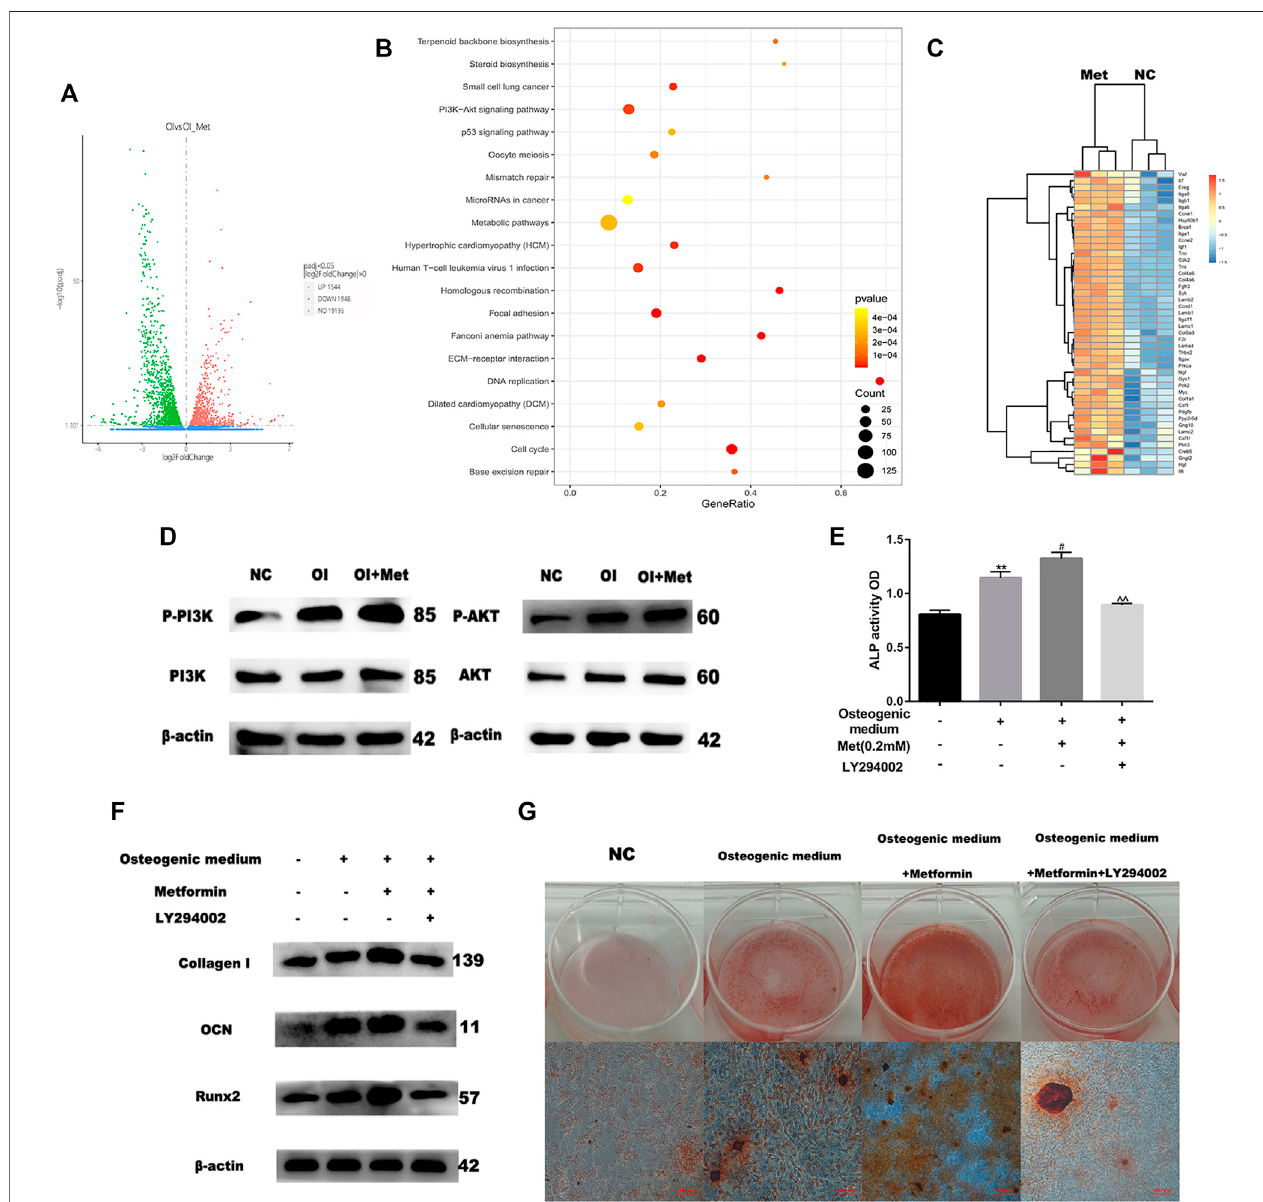
FIGURE 2 | Metformin induces osteogenic differentiation via the PI3K/AKT pathway. (A) Volcano map of differential genes as osteogenic induction (OI) vs. OI with metformin treatment (OI_Met). (B) Kyoto Encyclopedia of Genes and Genomes (KEGG) of up-regulated genes during metformin-induced osteogenic differentiation. (C) Heatmap of up-regulated genes involved in PI3K/AKT signaling pathway. (D) Protein expression of PI3K-AKT pathway, enhancing effect observed for metformin on PI3K/AKT expression. (E) ALP activity was detected to explicit metformin protection of osteogenic differentiation inhibited by H 2 O 2 was blocked by LY294002. (F) Protein expression of COLL-1, OCN and Runx2 after adding LY294002. (G) The activity of osteoblast mineralization decreased with LY294002 treatment detected by using Alizarin red S staining. Experiments were implemented in triplicate. Data are means ± SD, * p < 0.05, ** p < 0.01 compared with control cells and # p < 0.05, ## p < 0.01 compared with osteogenic induction alone and ^ p < 0.05, ^^ p < 0.01 compared with combined treatment of osteogenic induction and metformin analyzed by using ANOVA.